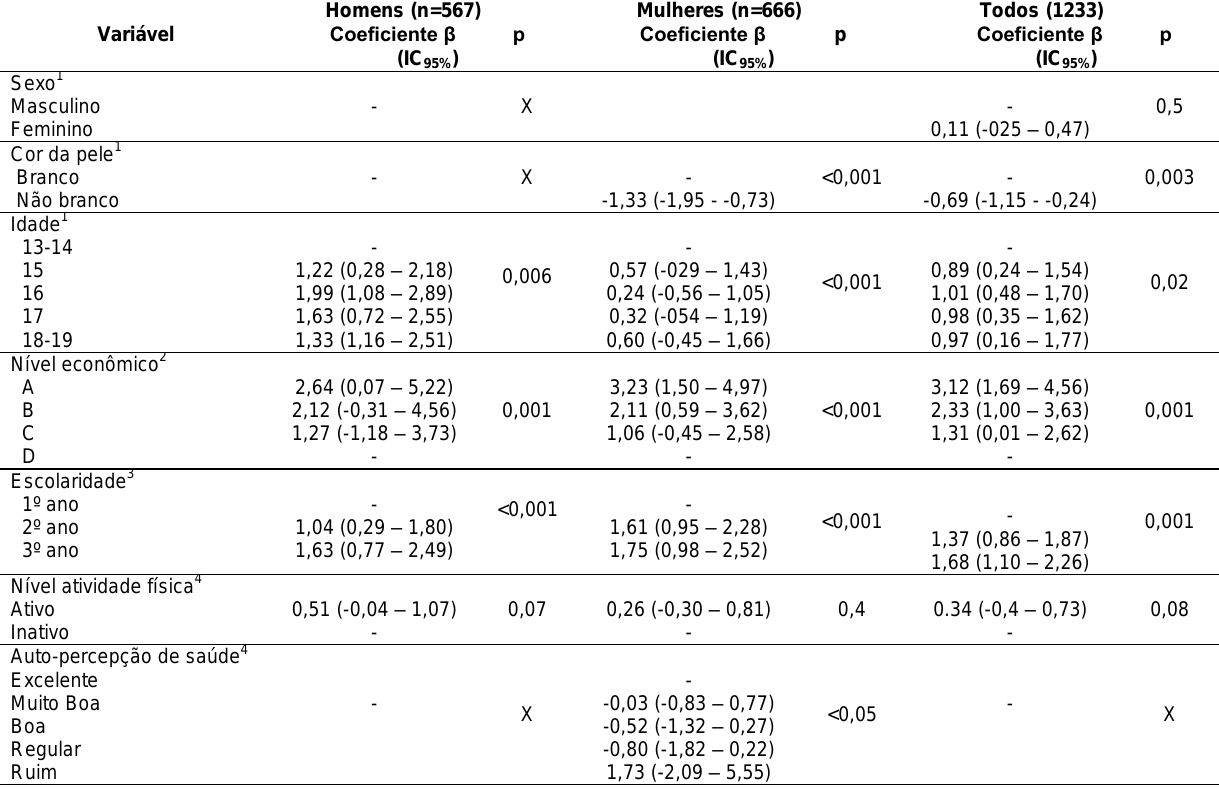
Tabela 5. Regressão linear múltipla entre conhecimento e as variáveis sexo, cor da pele, idade, nível econômico, escolaridade, atividade física e auto-percepção de saúde, para toda amostra e estratificada por sexo. Pelotas, Rio Grande do Sul, Brasil,